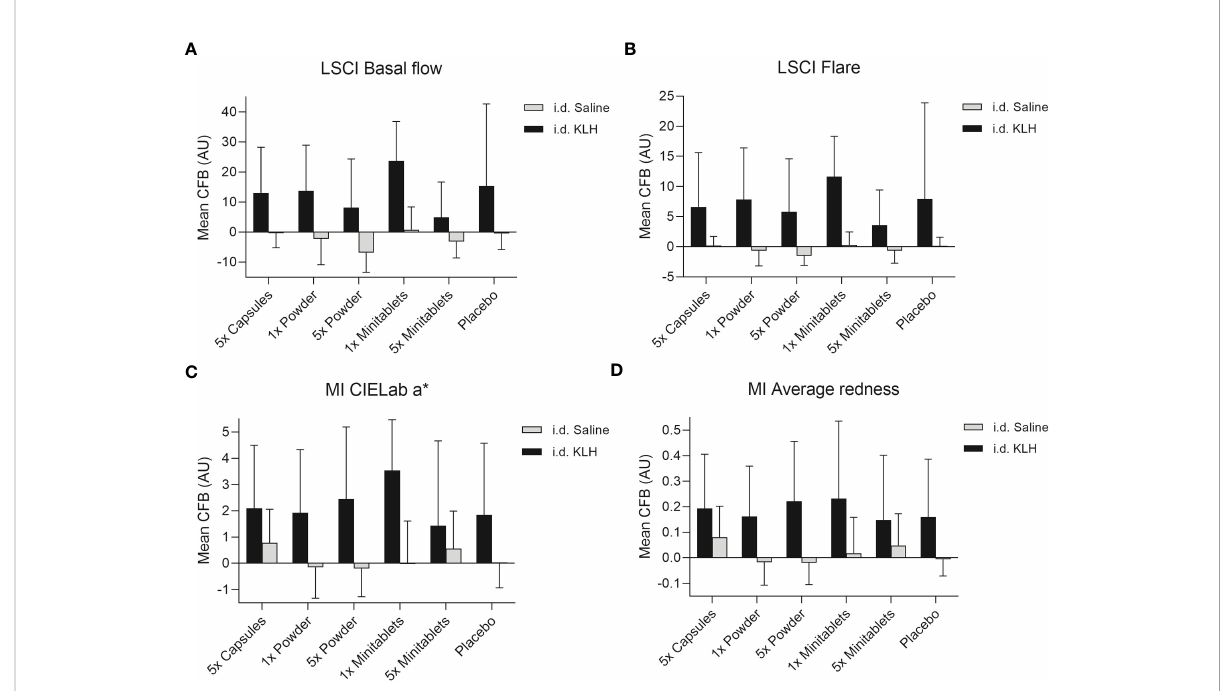
FIGURE 3 Cutaneous blood perfusion by (A) LSCI basal fl ow and (B) LSCI fl are, erythema by (C) CIELab a* (multispectral imaging), and (D) average redness (multispectral imaging) after intradermal KLH and saline administration by three EDP1066 formulations of Lactococcus lactis spp. cremoris : i) enteric-coated capsules, ii) freeze-dried powder (dose 1× and 5×), and iii) minitablets (dose 1× and 5×). The average redness modality displays the distribution of redness using an internal software algorithm and the CIELab a* value, which is part of the CIELab color space, expresses color as a numerical value on a green – red color scale. Data are shown as mean change from baseline (CFB) with standard deviation. LSCI, laser speckle contrast imaging; MI, multispectral imaging; KLH, keyhole limpet hemocyanin; CFB, change from baseline; AU, arbitrary unit; i.d.,